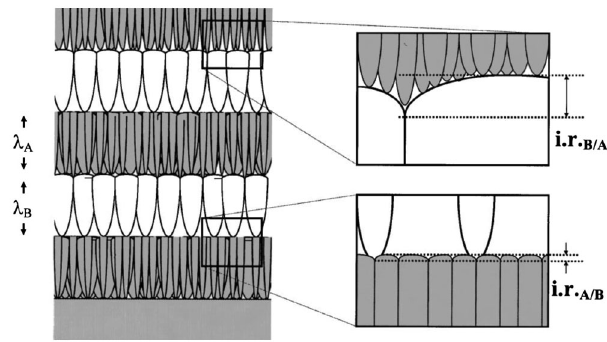
FIG. 2. Cross-sectional illustration of a hypothetical multilayer coating formed with equal (cid:1)A and (cid:1)B thicknesses. A difference of nucleation density between materials A and B can be noticed. This one induces a surface smoothening or a reverse effect according to the deposited sublayer and so, interfacial roughness (i.r. in the figure) can be strongly modified (reproduced from Ref. [10] with permission from the American Institute of